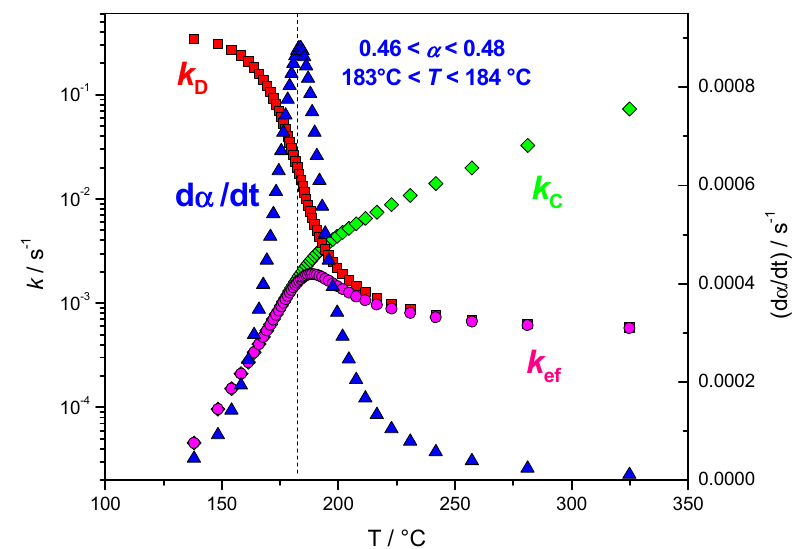
Figure 8. Blue triangles: variation of (d α /d t ) computed as the product of [ A α f ( α )] by exp[ − E α /( RT α )] with temperature, red squares: variation of k D with temperature, green lozenges: variation of k C with temperature, magenta circles: variation of k ef with temperature.